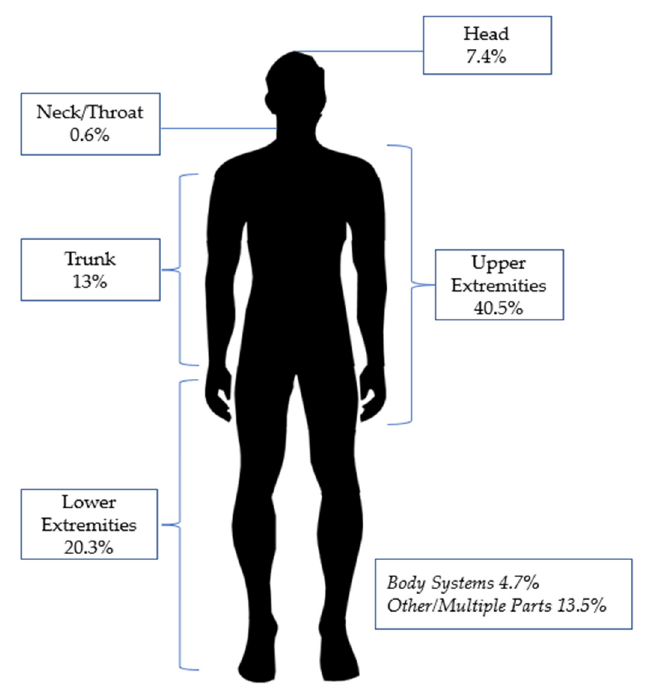
Figure 1. Percentage of the affected body part(s).